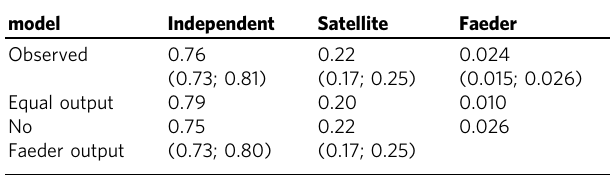
The “ Observed ” model considers the observed differences in female reproductive output between morphs. The “ Equal output ” model does not consider the differences in reproductive output betweenfemale morphs.The thirdmodelassumes thatFaeder femalesdonot reproduce ( “ No Faeder output ”